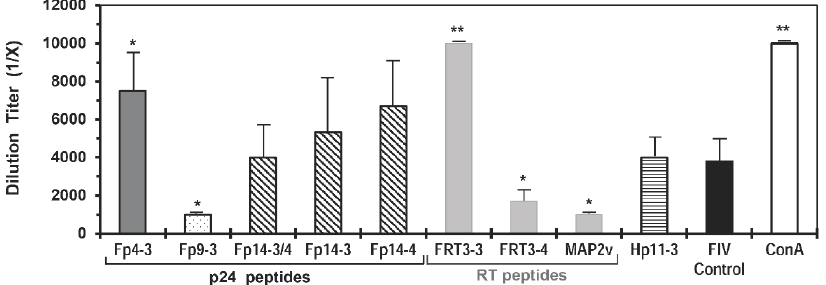
MAP tested are FIV reverse transcriptase peptides FRT3-3, FRT3-4, and MAP2v (grey bar); FIV p24 peptides Fp9-3 (dotted bar); Fp14-3, Fp14-4, and overlapping Fp14-3/Fp14-4 (Fp14-3/4) (slanted line bar); and p24 peptide Fp4-3 (dark grey bar) as the positive control for peptide-induced enhancement. MAP2v contains the overlapping FRT3-3/FRT3-4 peptide. T-cell mitogen control (concanavalin